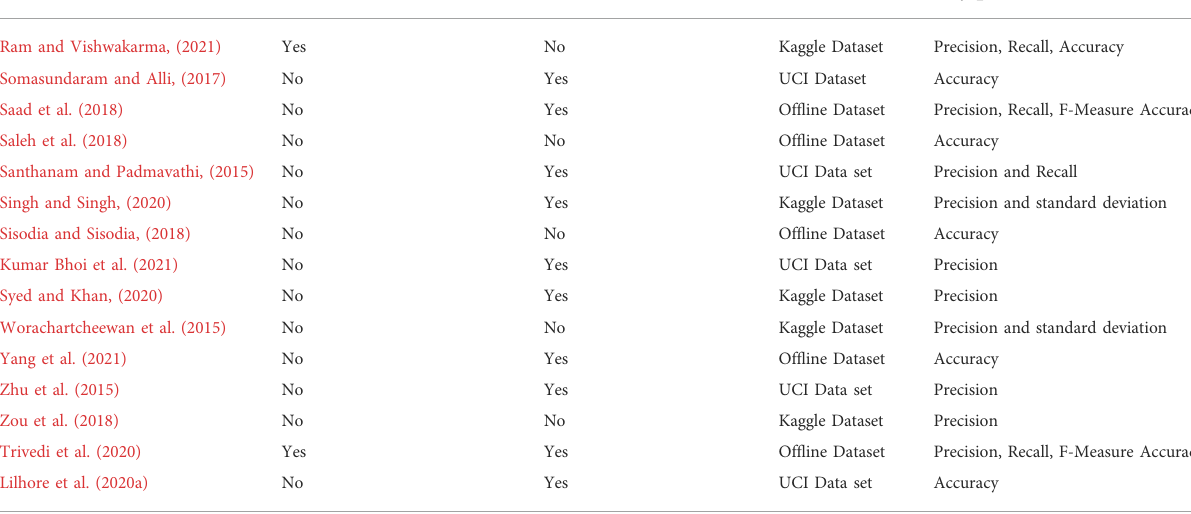
TABLE 1 Comparative study of various diabetes prediction Methods.